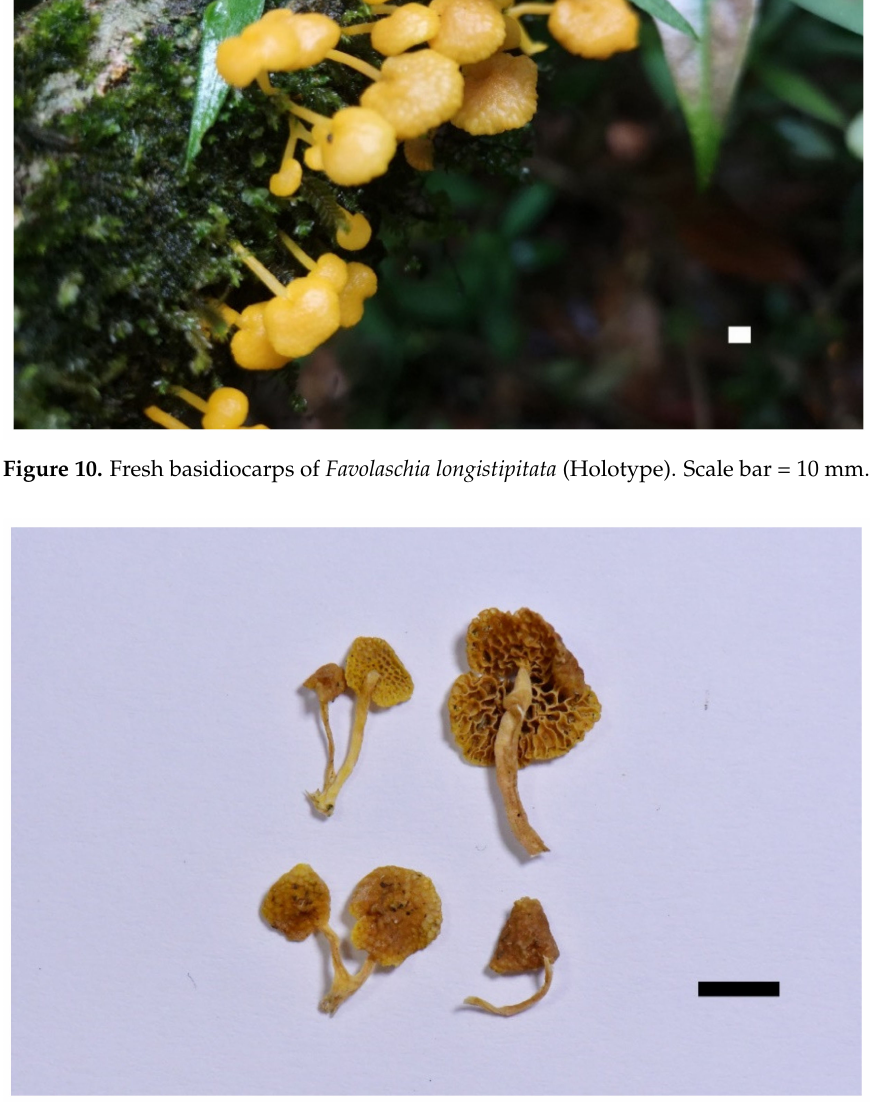
Figure 11. Dried basidiocarps of Favolaschia longistipitata (Holotype). Scale bar = 5